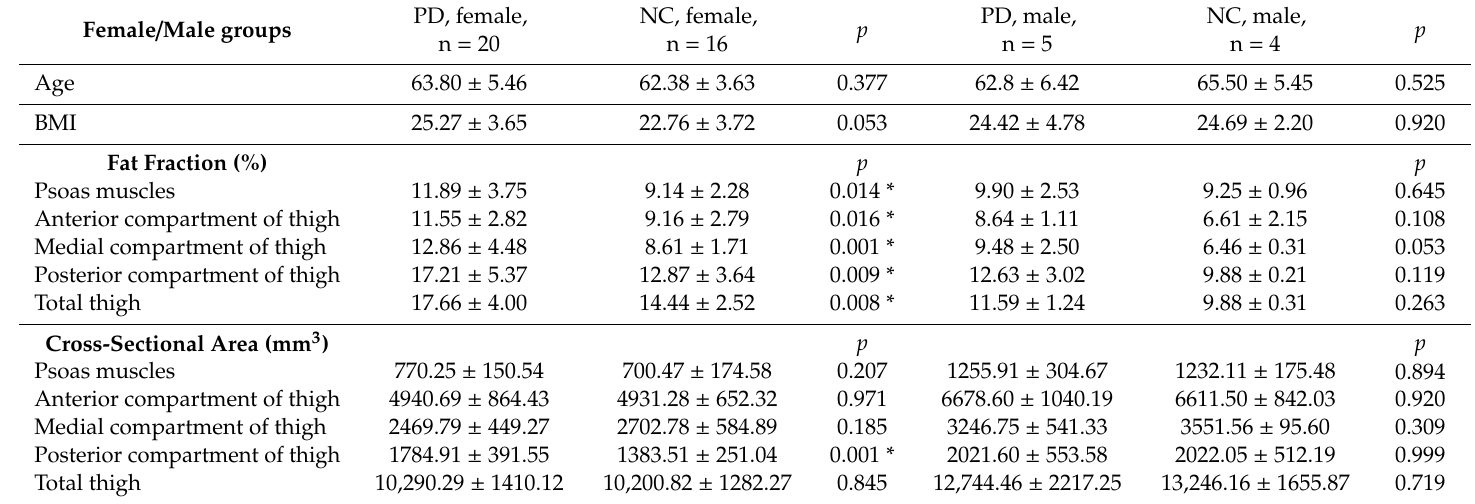
Table 4. Comparison of fat fraction and cross-sectional areas (mm 3 ) in female and male